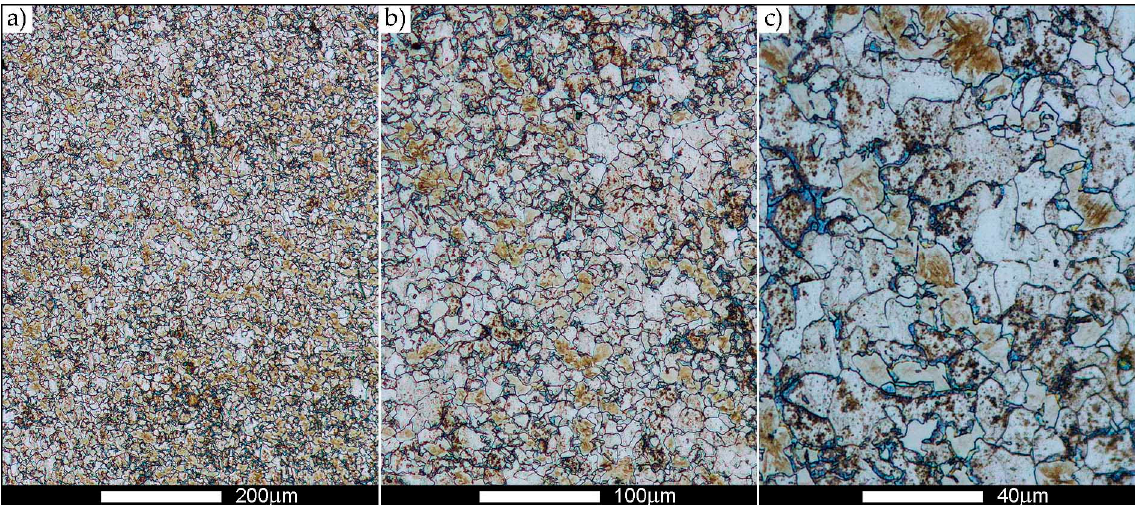
Figure 32. Welded joint microstructure of Hardox 450 steel with visible grain boundaries of prior austenite, austenitised at 1000 °C—WM1 zone shown in Figure 2. ( a ) 100×; ( b ) 200×; ( c ) 500×.